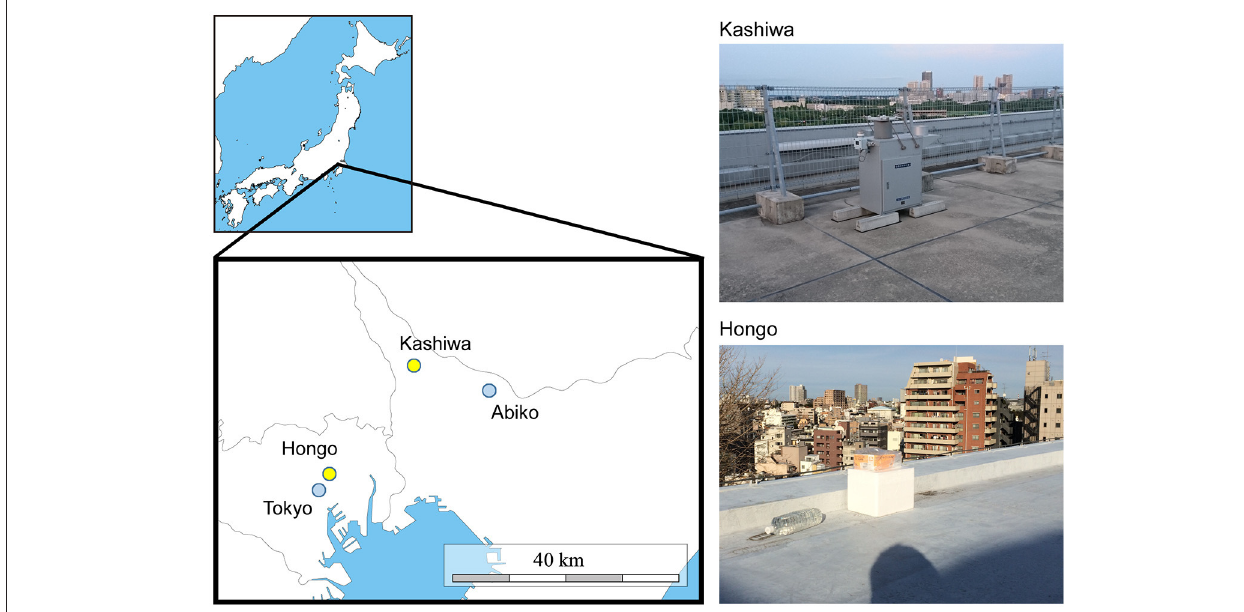
FIGURE 1 | A map of the sampling sites (Kashiwa and Hongo, yellow) and meteorological observatories (Abiko and Tokyo, blue) (left panel), with photos of the sampling sites (right panel). At the Kashiwa site, a US-330 automatic precipitation sampler (Ogasawara Keiki, Tokyo, Japan) was installed. At the Hongo site, precipitation samples were manually